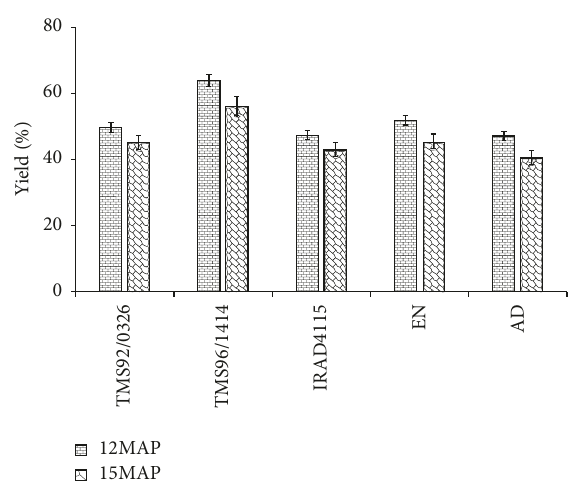
Figure 1: Effect of the harvest period (12 and 15 months after planting) on gari yield (g/100g of wet mash). Garis are produced from local ( EN and AD ) and improved ( TMS92/0326, TMS96/1414, and IRAD4115 ) cassava varieties harvested in dry season at 12 months and in rainy season at 15 months after planting (12MAP and